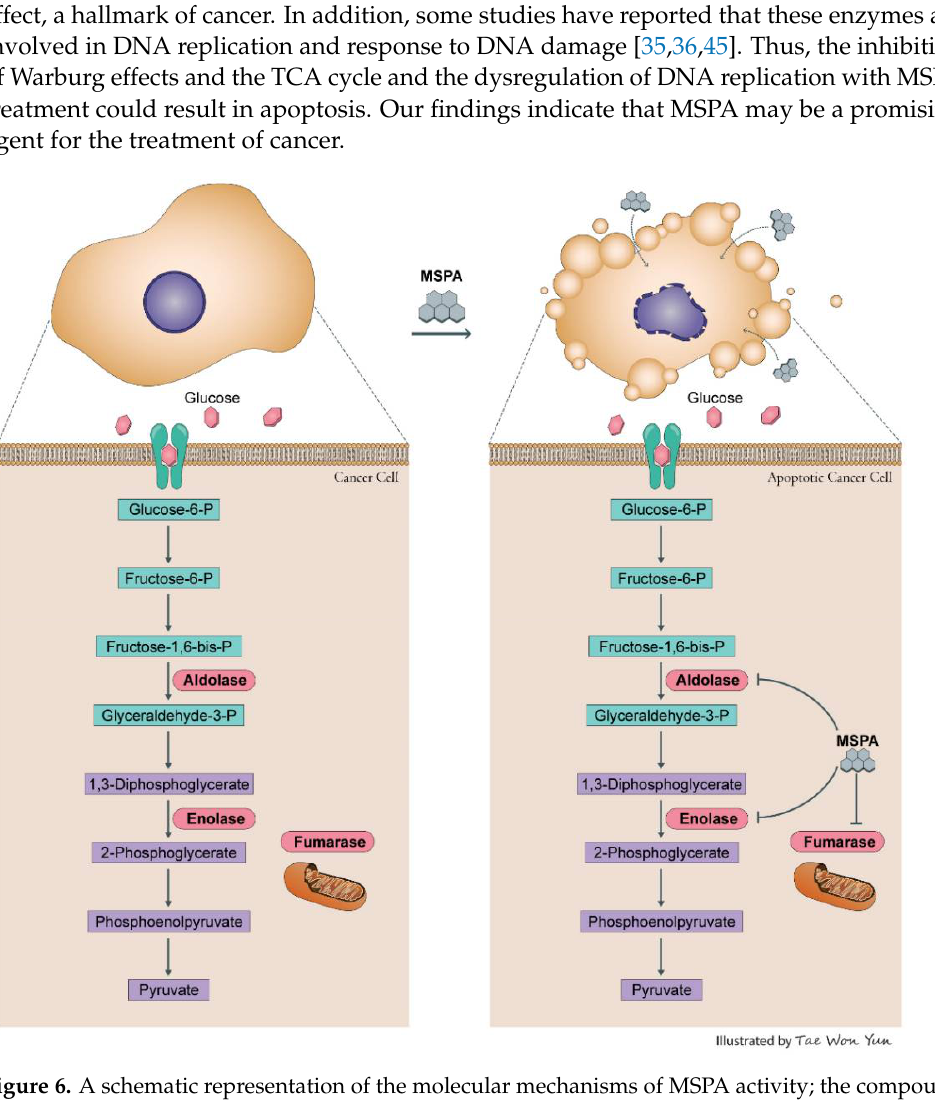
Title , Figure S2: , Figure S3: , Figure S4: , Figure S5: , Figure S6: , Figure S7: , Table S1: .